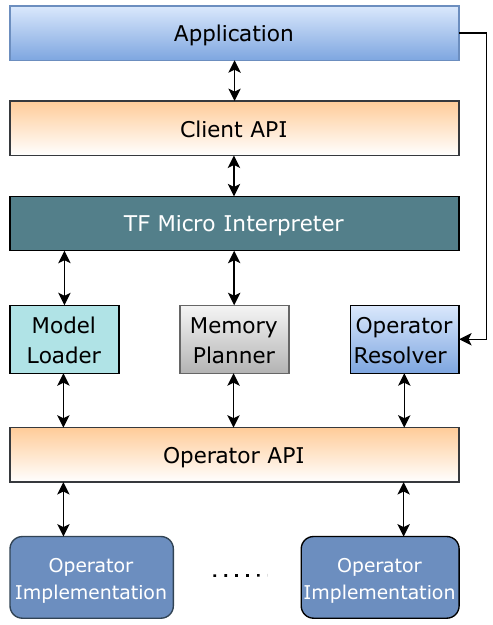
Figure 13. Implementation overview